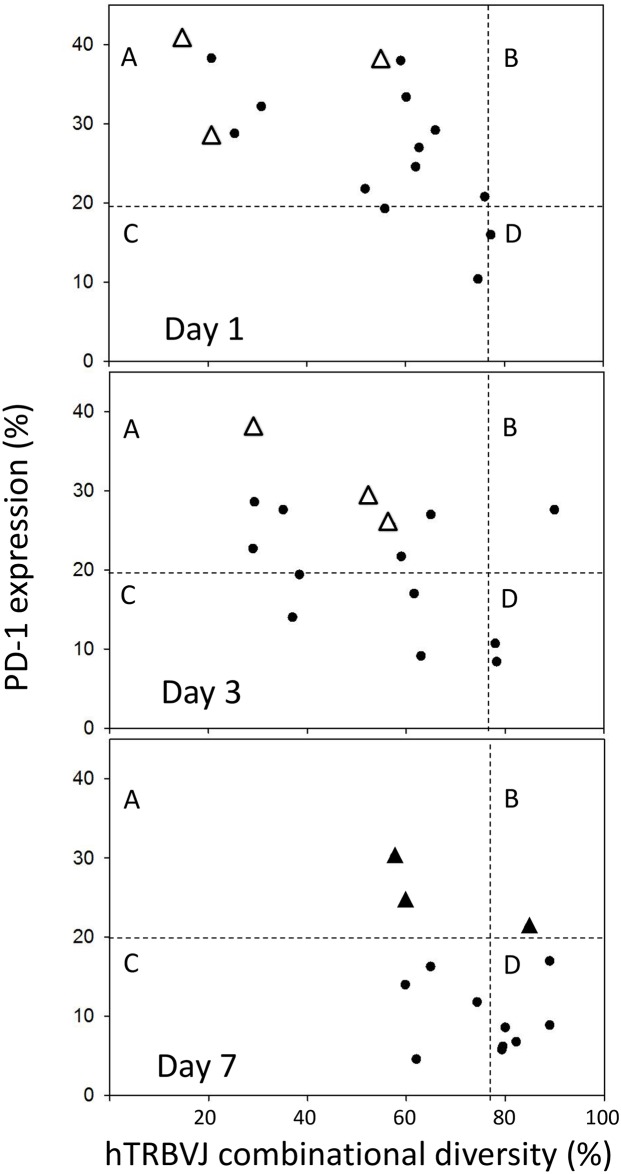
TCR diversity plotted versus PD-1 expression on quadrant charts for days 1, 3, and 7.Each chart is divided into four zones limited by the normal threshold of TCR diversity (78.3% based on lower quantile data from healthy volunteers) and the normal threshold of PD-1 expression (19.5% based on upper quantile data from healthy volunteers). Patients with CMV reactivation who died are indicated by closed triangles on day 7 and by open triangles on days 1 and 3. Group A: high PD-1 expression with low TCR diversity; group B: high PD-1 expression with normal TCR diversity; group C: normal PD-1 expression with low TCR diversity; group D: normal PD-1 expression with normal TCR diversity. Results are presented as individual values.